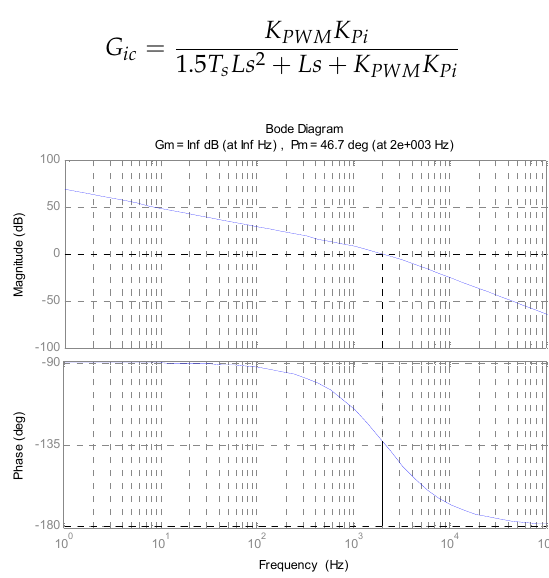
Figure 6. Bode plot of the open loop frequency response for the inner current loop.